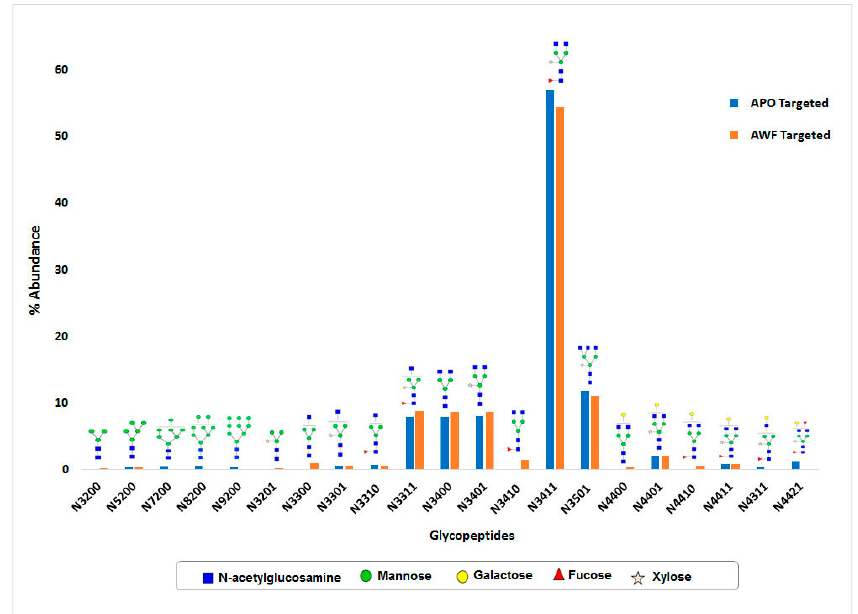
Figure 6. N -glycan distribution analysis of rCMG2-Fc-Apo purified from whole leaf extract (APO) and apoplast wash fluid (AWF). Different glycan structures observed at the N -linked glycosylation site on the Fc region. The abundance of each glycan structure is represented in a bar chart. The annotation on the x -axis represents N -glycan-number of Mannose and Galactose residues/number of GlucNAc residues/number of Fucose residues/number of Xylose residues.